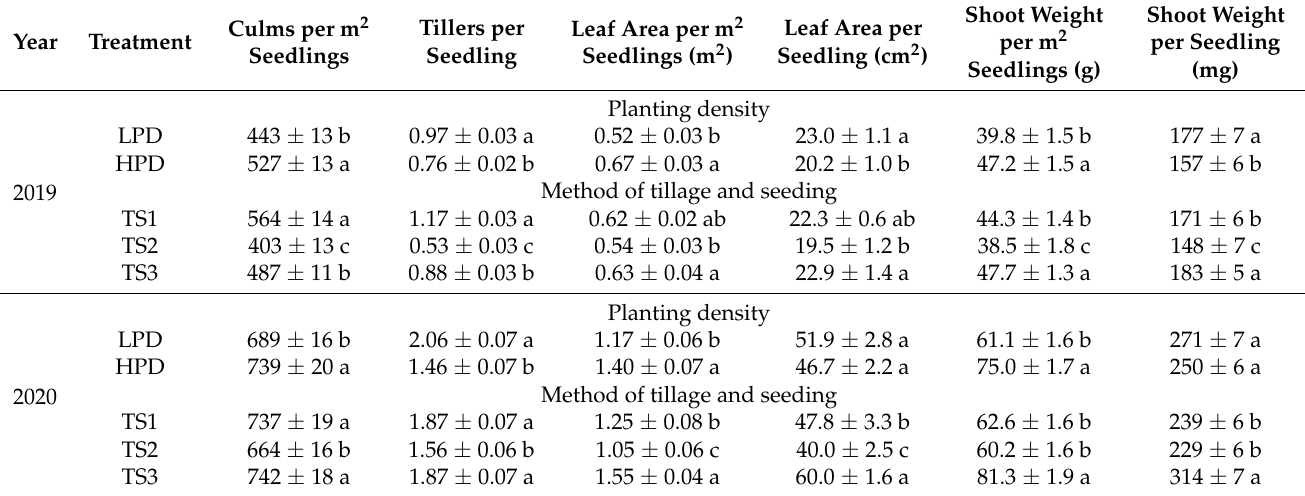
Table 1. Effects of planting density and method of tillage and sowing on seedling growth in 2019 and